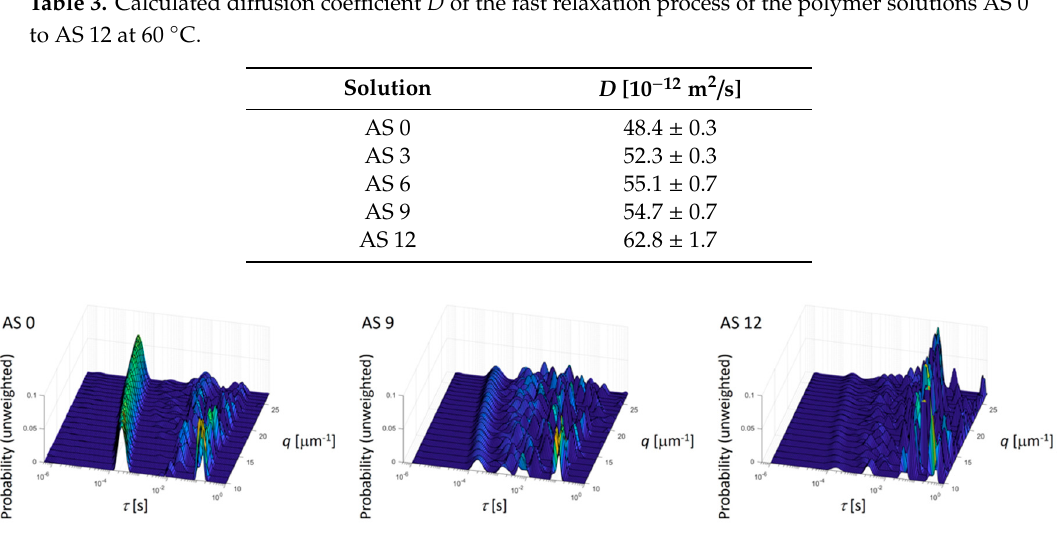
Figure 9. Relaxation time spectrum of the solutions AS 0, AS 9, and AS 12 as determined by the CONTIN algorithm for all measured scattering vectors.